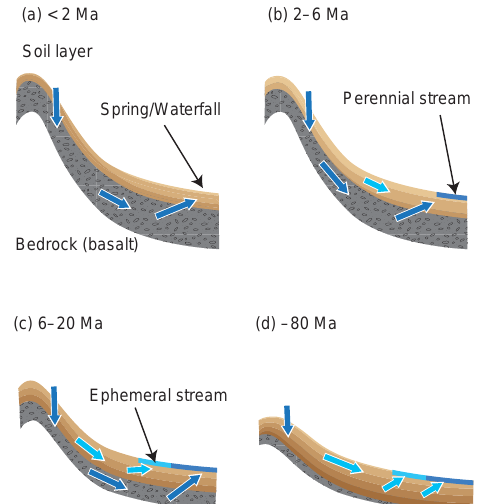
Figure 20. Conceptual model describing coevolution in volcanic catchments. In the early stages of evolution, deep groundwater flow in the bedrock (deep blue arrows) is the dominant flow pathways. As time progresses, subsurface impermeable layers develop (deepening of color in soil layer), and the major flow pathways change from vertical flow to shallow subsurface flow (light blue